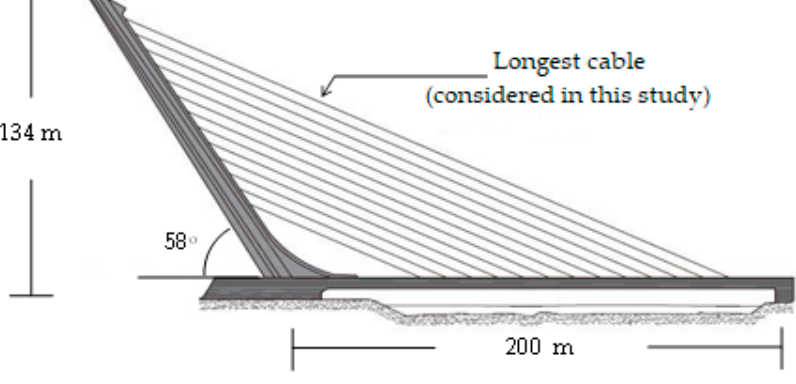
Figure 4. Illustrative scheme of the Alamillo bridge.